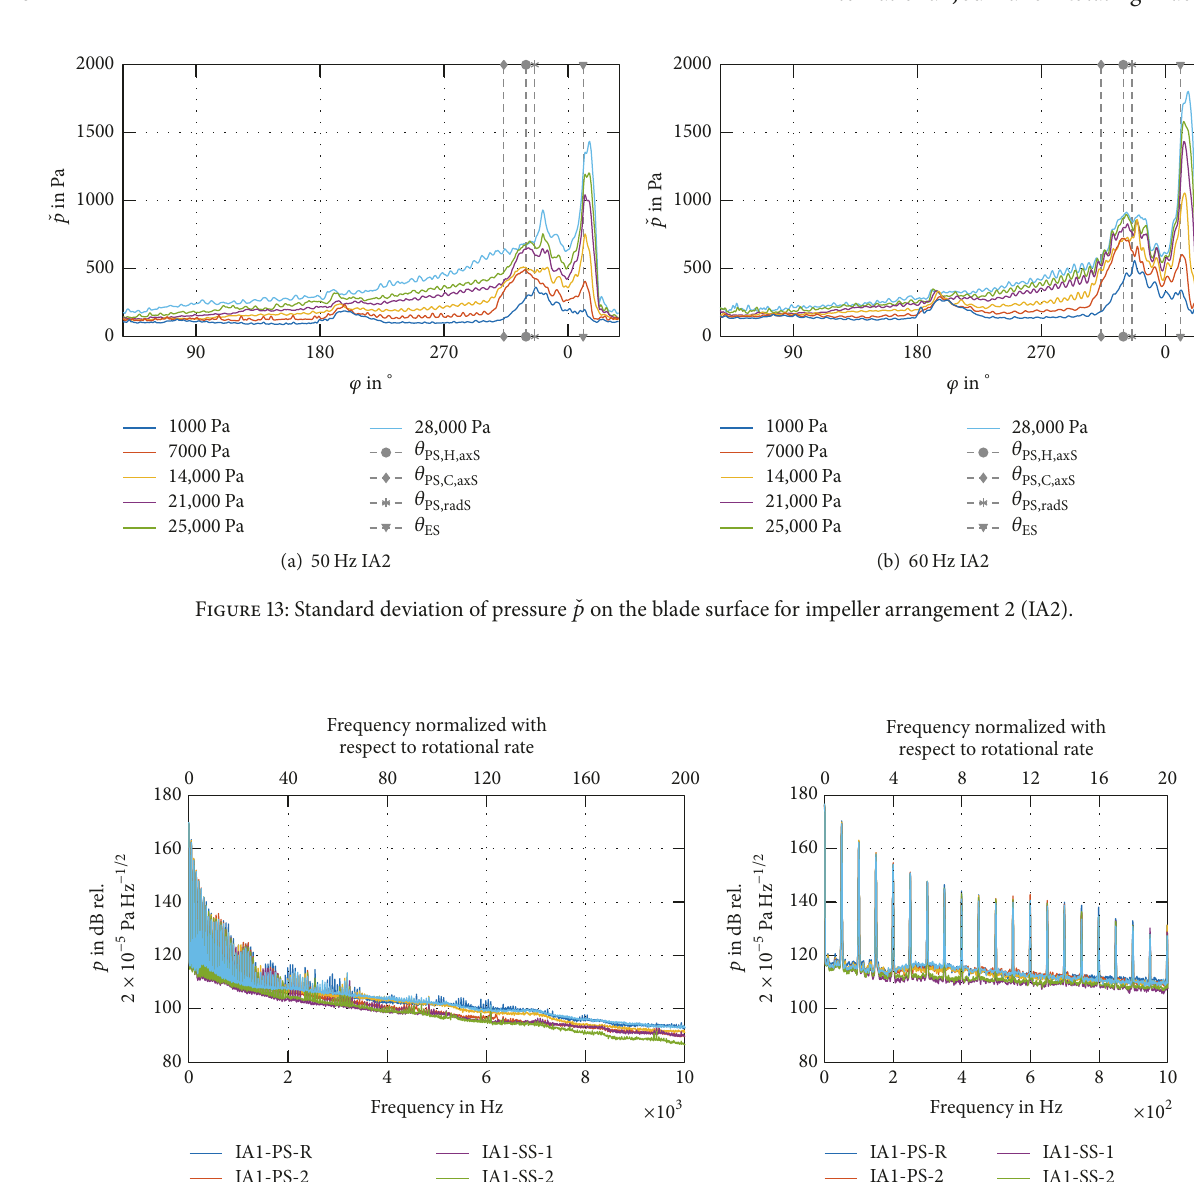
located at fixed positions as periodic oscillations occur along the side channel, especially in the range of 𝜑 = 200 ⋅ ⋅ ⋅ 300 ∘